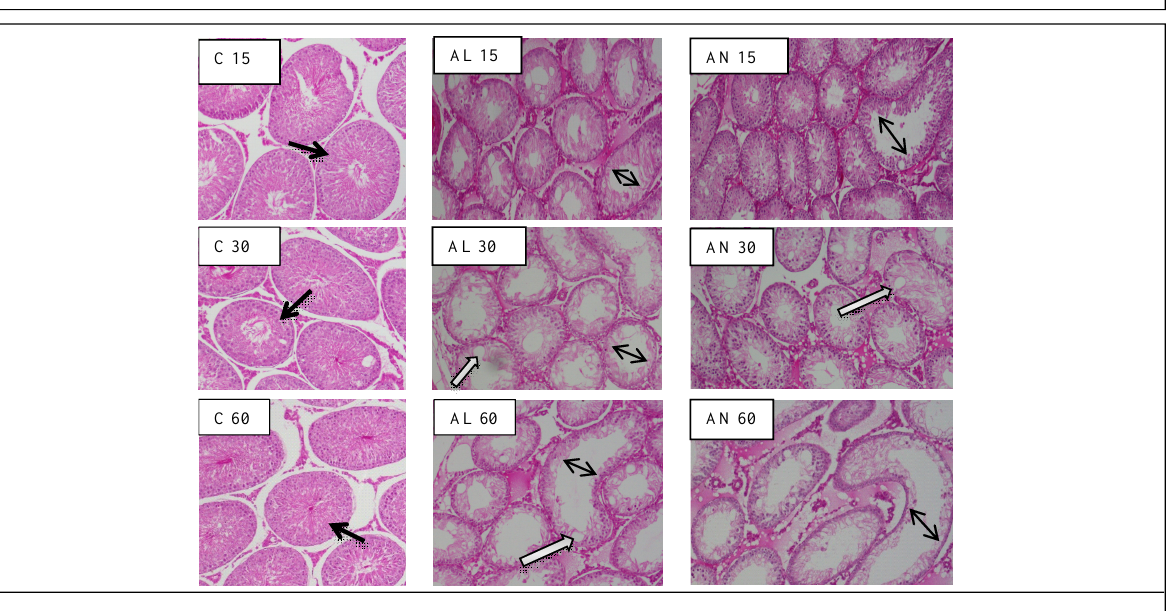
Figure 5a: Histopathology. M. natalensis rat’s testes at x100 Note: Upper row (15 days treated) groups: C = control: normal seminiferous tubule (ST) with intact germinal epithelium, adlumen, and lumen (Single black arrows). AL= A. lebbeck treated group: Normal ST and ST with damaged germinal epithelium, adlumen and widened lumen (Double black arrows), intraepithelial vacuolation (White arrow). AN = A. nilotica treated group: Normal ST and ST with damaged germinal epithelium, adlumen and widened lumen (Double black arrows), intraepithelial vacuolation (White arrow). Middle row (30 days treated) and lower row (60 days treated) groups: C = control groups: normal seminiferous tubule (ST) with intact germinal epithelium, adluminal, and lumen (Single black arrows). AL= A. lebbeck treated group: ST with exfoliated germinal epithelium, damaged adlumen and widened lumen (Double black arrows), intraepithelial vacuolation (White arrow). AN = A. nilotica treated group: exfoliated germinal epithelium, disrupted adlumen and widened lumen (Double black arrows), intraepithelial vacuolation (White